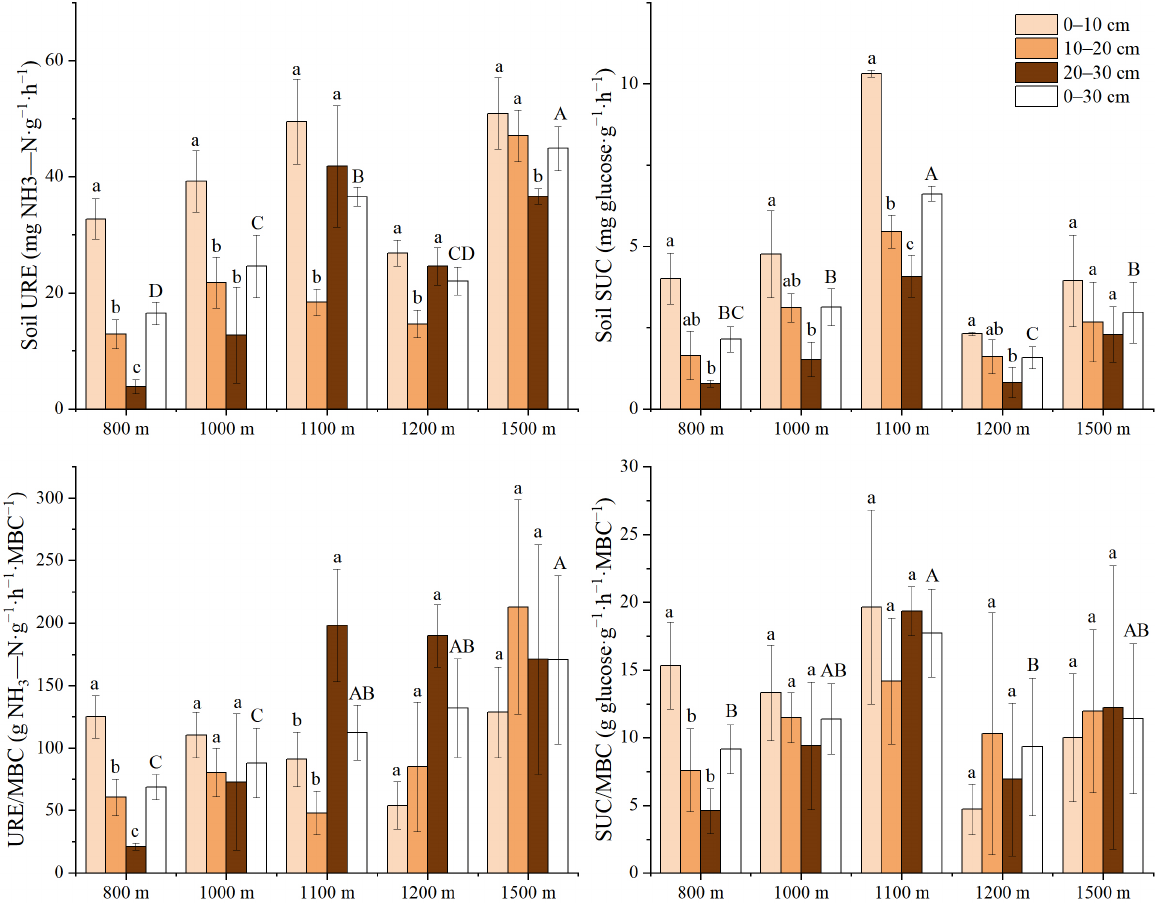
Figure 4. Absolute and relative activities of soil enzymes at different elevations. Different lowercase letters indicate significant differences between different soil layers at the same elevation gradient ( p < 0.05). Different capital letters indicate significant differences along different elevation gradients ( p < 0.05).